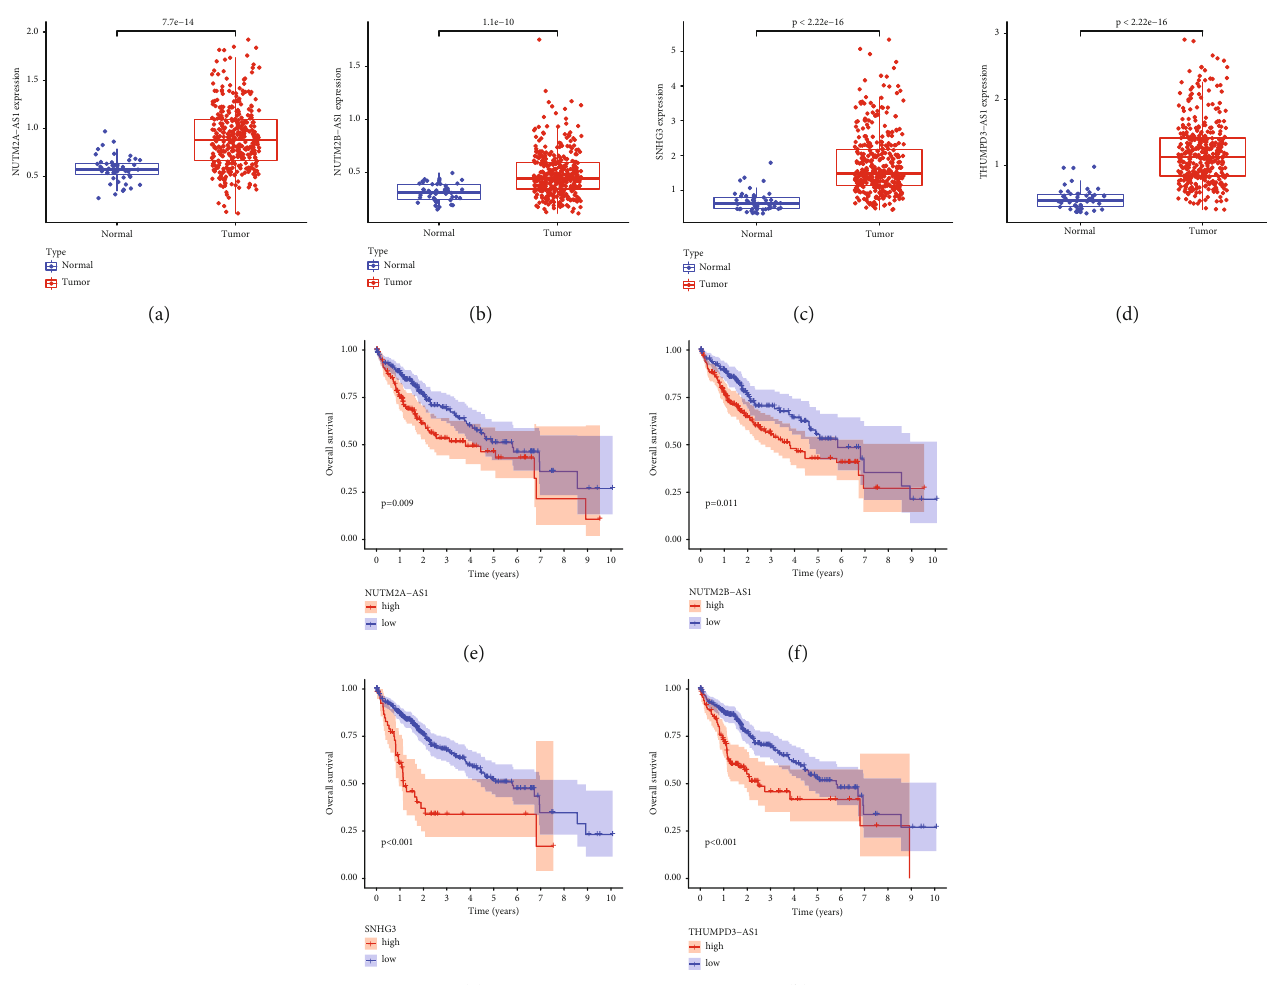
Figure 5: Expression analysis and survival analysis for upstream lncRNAs of hsa − miR − 139 − 5p in LIHC. (a) – (d) The expression of NUTM2A − AS1 (a), NUTM2B − AS1 (b), SNHG3 (c), T HUMPD3 − AS1(d). (f) – (j) The OS analysis for NUTM2A − AS1 (e), NUTM2B − AS1 (f), SNHG3 (g), and T HUMPD3 − AS1 (h) in LIHC. Table 1: Correlation analysis between lncRNA and hsa-miR-139-5p or LPCAT1 in LIHC determined by the starBase database. lncRNA Gene/miRNA Cor p value NUTM2A-AS1 LPCAT1 0.311045764 THUMPD3-AS1